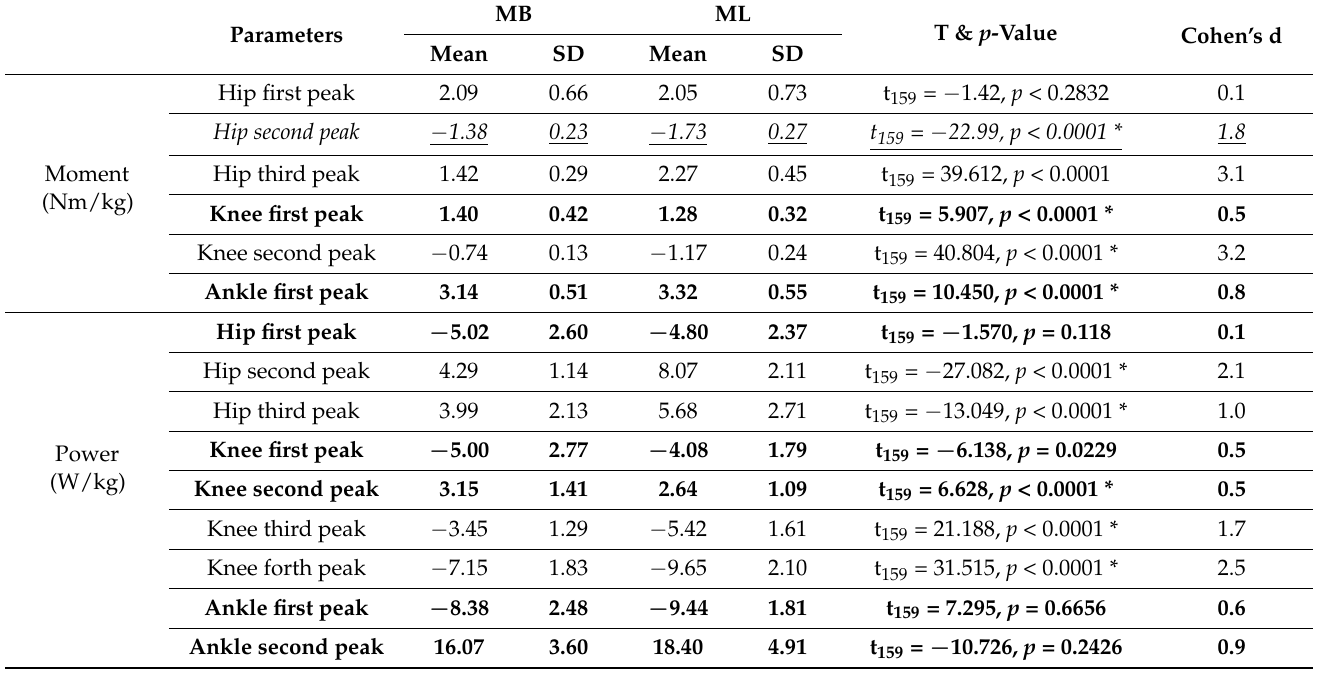
Table 1. Body mass scaled peak magnitude (Mean, SD) for joint moments and powers for the marker-based (MB) and Markerless (ML)